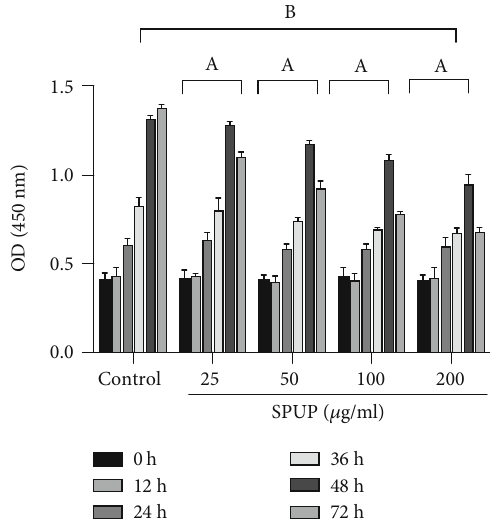
Figure 2: E ff ect of SPUP on the proliferative activity of DU145 cells. Compared with the control group, A: < 0.05; within-group comparison of di ff erent time points at the same concentration, B: <